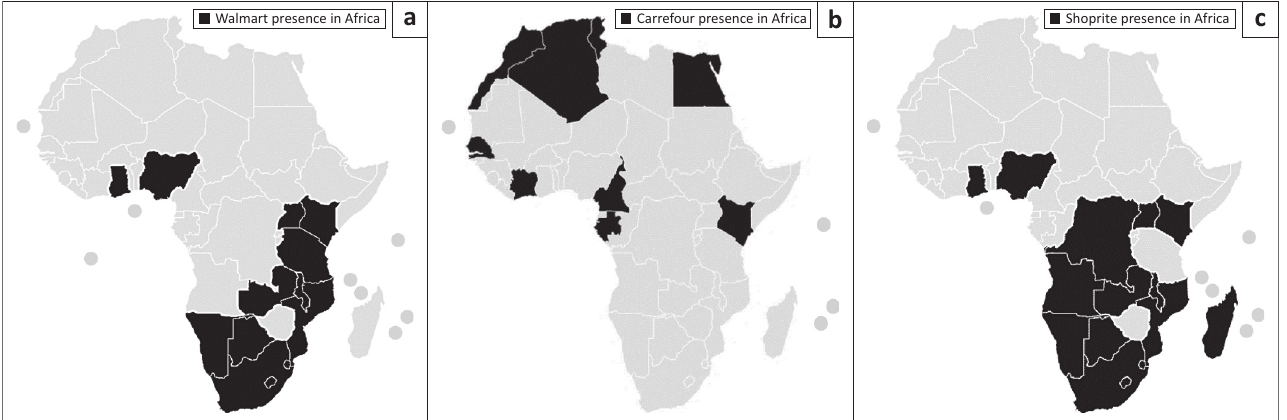
FIGURE 3: Footprint of (a) Walmart, (b) Carrefour and (c) Shoprite in Africa.